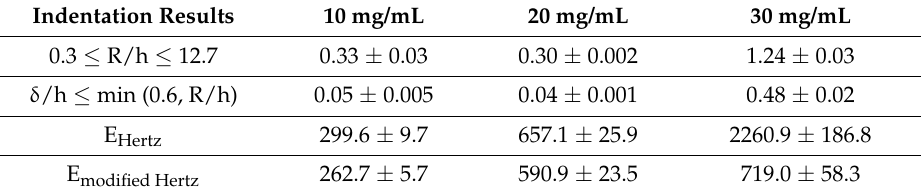
Table 1. Indentation parameters and elastic moduli values obtained for fibrin samples.